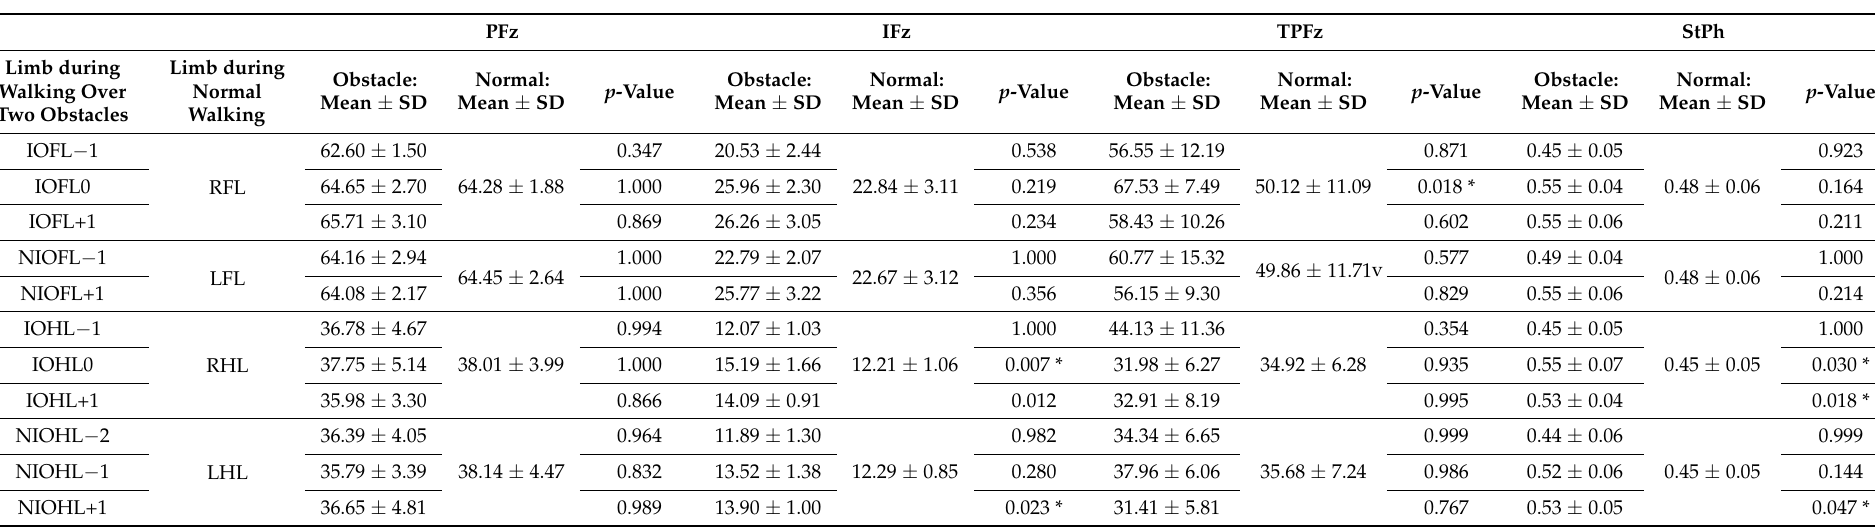
Table A3. Mean values, standard deviations, and significant differences in ground reactions forces between walking over two obstacles and normal walking.